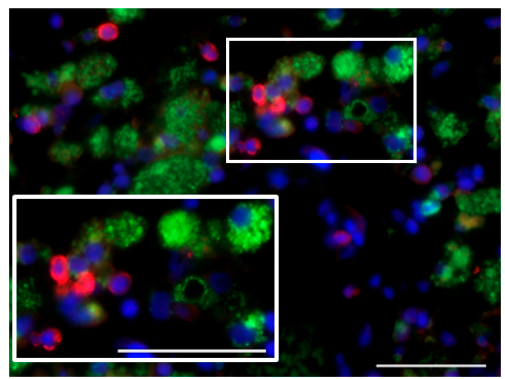
Figure 1. Intra- and perivascularly located cluster of differentiation (CD)40 + cells lacking CD68 expression infiltrate the tumor of an intravenously parvovirus-treated glioblastoma patient. CD40, red; CD68, green; DAPI, blue. Scale bars: 50 μ m.